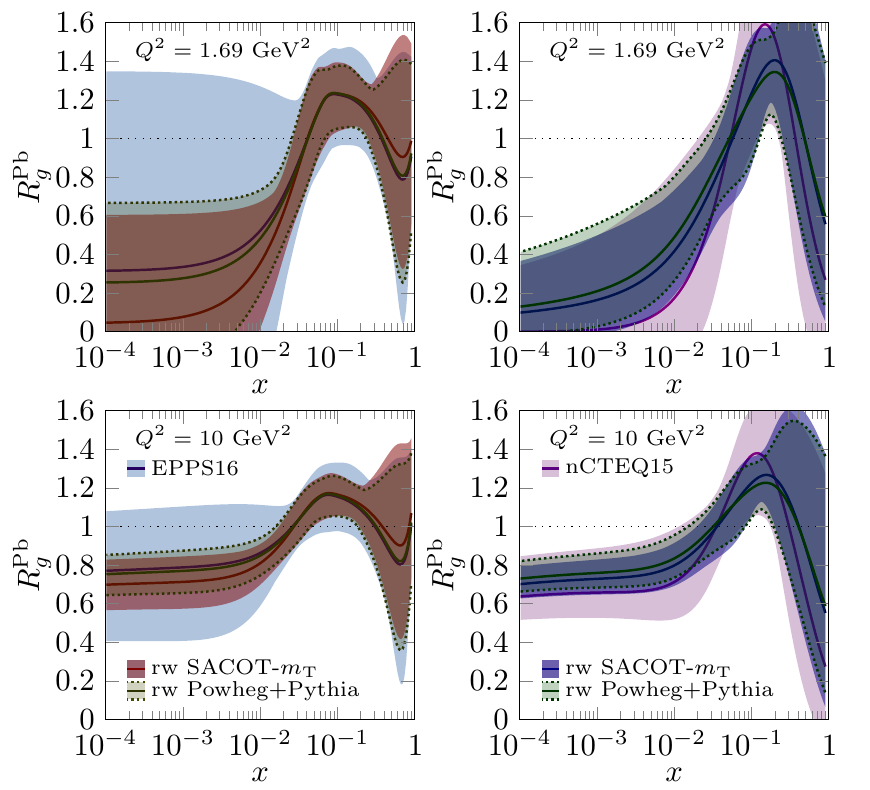
Figure 14 . The EPPS16 (left) and nCTEQ15 (right) nuclear modi(cid:12)cations for bound-proton PDFs in Pb nucleus before (EPPS16 blue, nCTEQ15 purple) and after reweighting with the LHCb data with SACOT- m T (EPPS16 red, nCTEQ15 blue) and with Powheg (green with dashed error-band limits) frameworks with a cut P T > 3 GeV. The results are shown for gluons at Q 2 = 1 : 69 GeV 2 (upper panels) and at Q 2 = 10 GeV 2 (lower